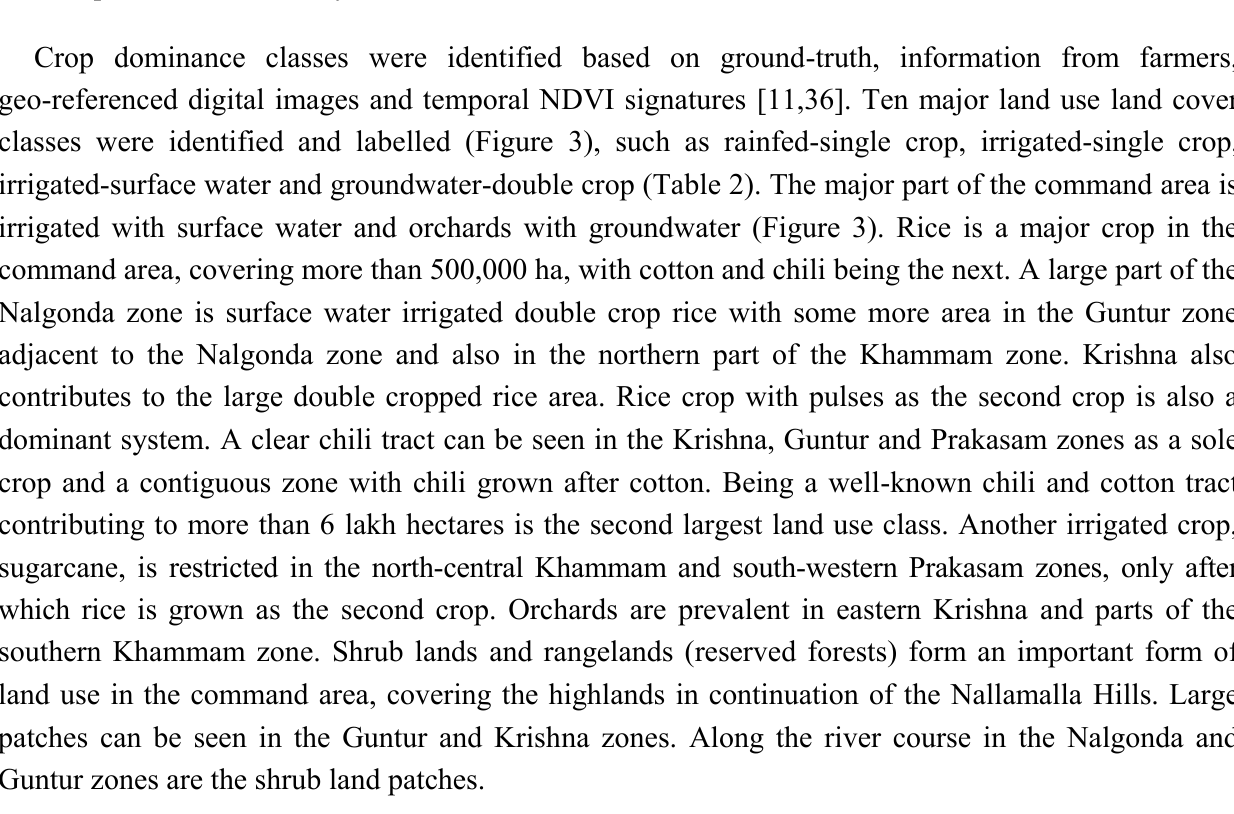
Figure 3. The 10 crop dominance classes of the Nagarjuna Sagar command area based